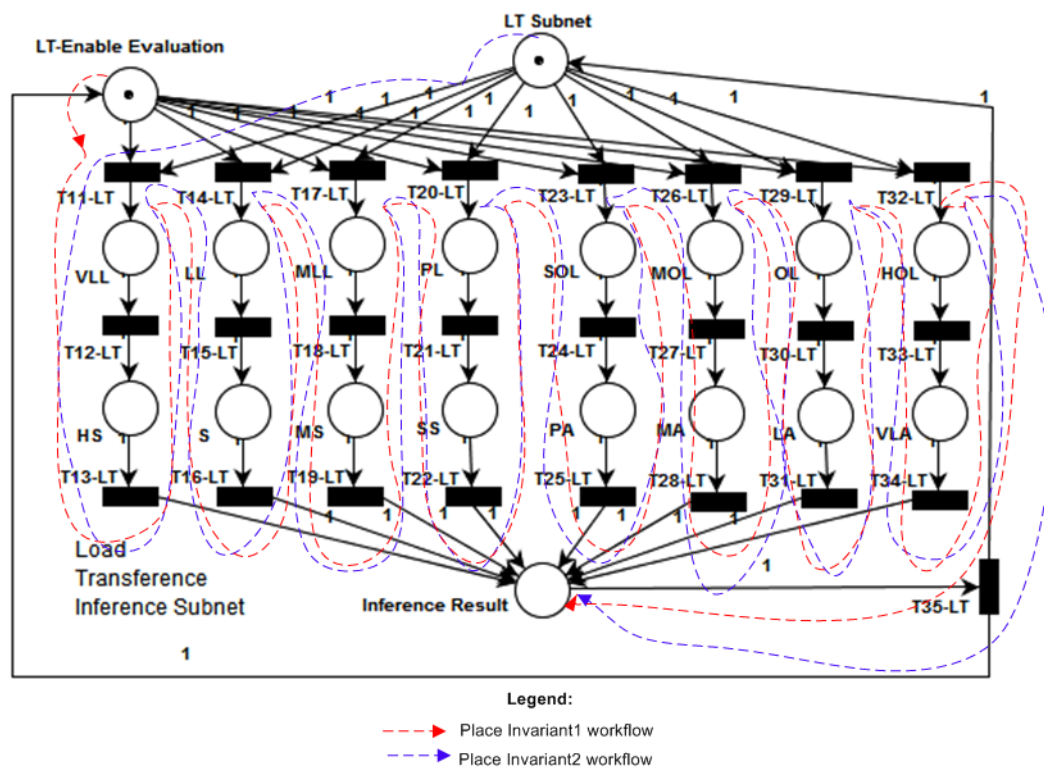
Figure 12. LT subnet- Place-Invariant workflow